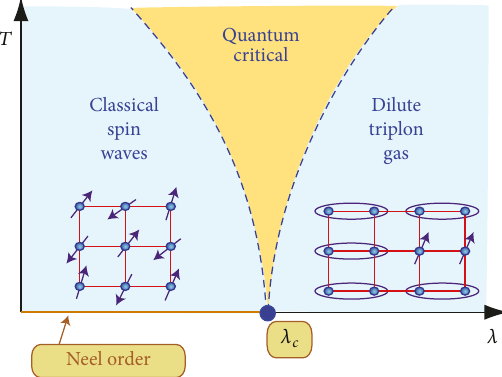
Figure 2: Schematic illustration of the SC and AF phases of HTSC. For 𝜆 < 𝜆 푐 , the system favors AF alignment of neighboring spins. For 𝜆 > 𝜆 푐 SC emerges. The quasiparticles in the AF phase spin waves and in the SC phase they are “triplons,” dimers consisting of two neighboring spins which are aligned parallel to each other. In between the AF and SC phases there is a pseudogap phase which consists of a mixture of SC and AF